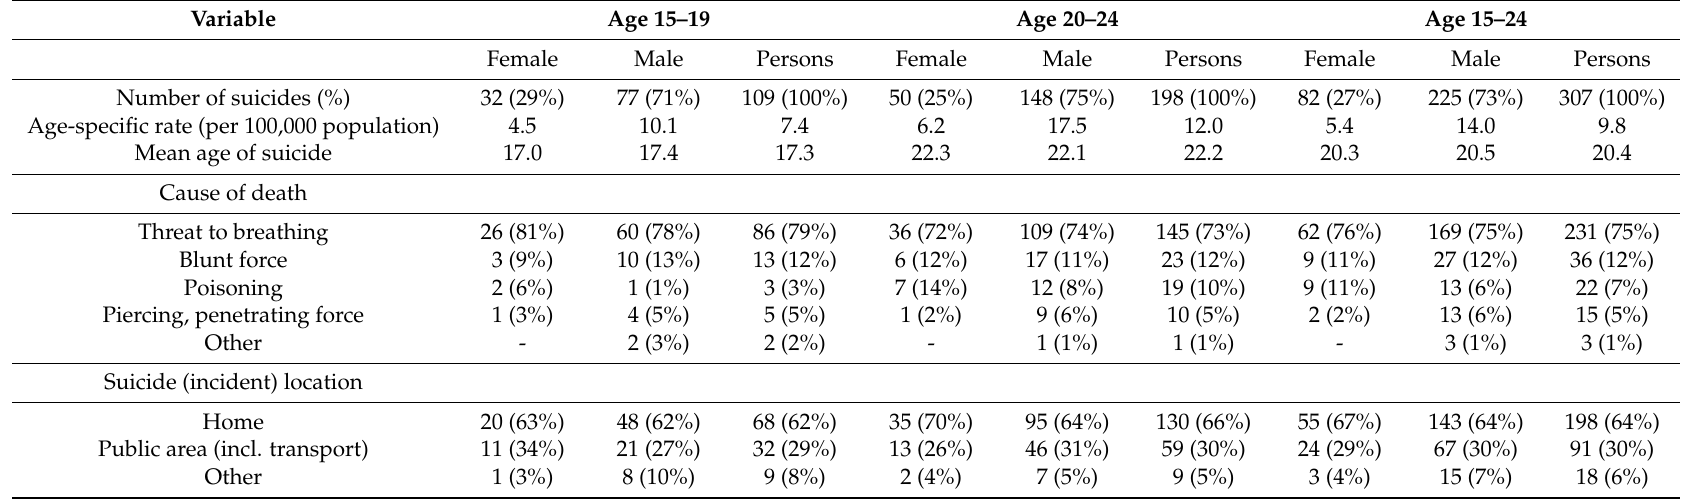
Table 2. Profile of youth suicide (15–24 years old) in Australia,